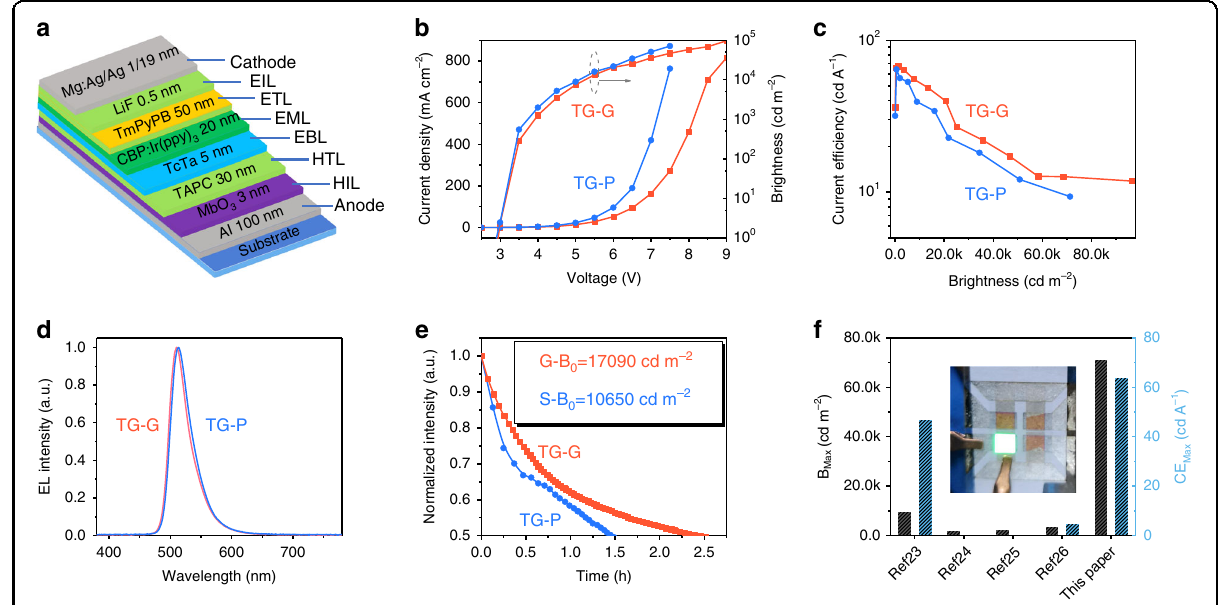
Fig. 2 Device performances of “ TG-P ” and “ TG-G ” . a Schematic diagram of the device structure of OLEDs. b Current density – voltage – brightness, ( c ) current ef fi ciency – brightness characteristics of green devices “ TG-P ” and “ TG-G ” . d Normalized spectra of green devices “ TG-P ” and “ TG-G ” . e Normalized intensity of devices “ TG-P ” and “ TG-G ” as a function of the operation time, with an initial brightness of L 0 = 10,650 cd m − 2 and L 0 = 17,090cd m − 2 at constant driving current. f Maximum brightness and maximum current ef fi ciency of paper-based OLEDs in reference papers and this work. The inset picture shows device “ TG-P